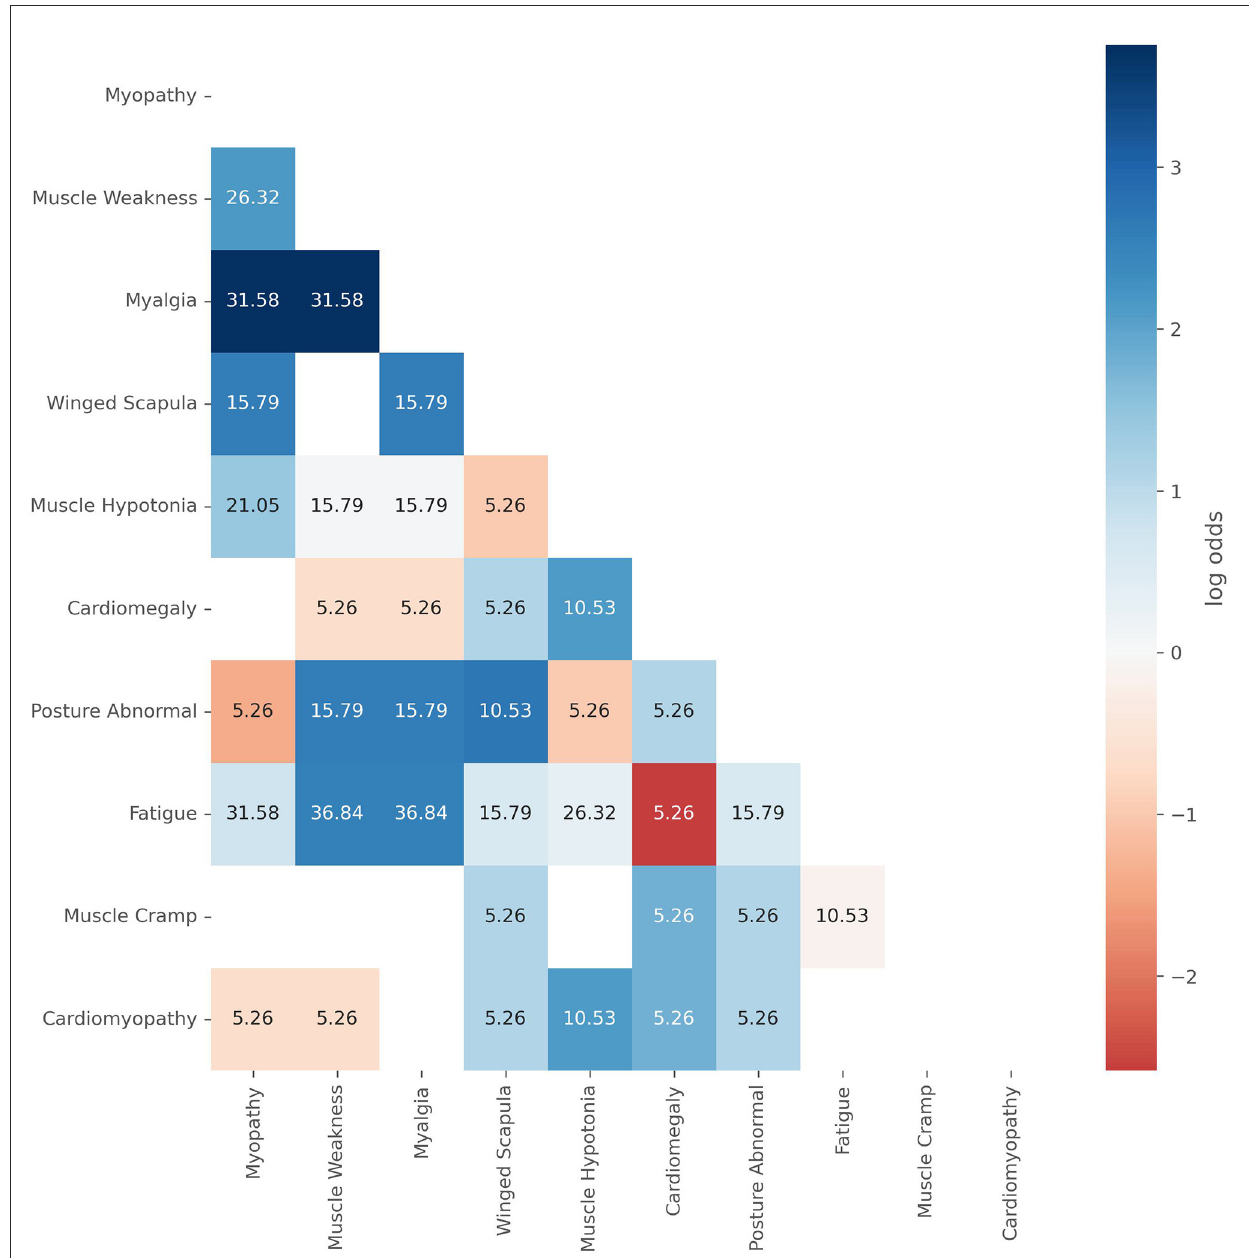
FIGURE4 The co-occurrence, given as the text annotation, and the log odds ratio (LOR) of characteristics found within the positive cohort as color code. The co-occurrence is the percentage of the cohort with both of a given characteristic while the LOR indicates if that characteristic pairing appears more or less than expected by chance, given their independent rates of occurrence. A LOR above zero indicates enrichment for a given pairing, while a value lower than zero indicates the pairing occurs less than expected. All elements left blank have an infinite LOR as the characteristics always occur